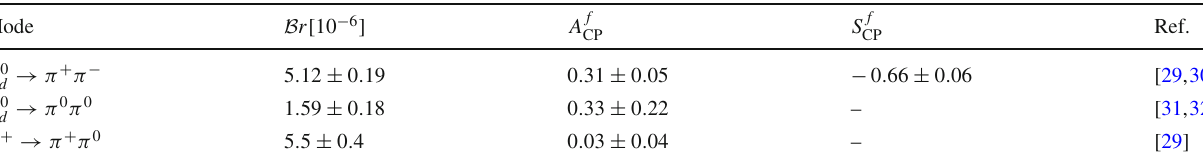
Table 1 Overview of the currently available B → ππ measurements. Note that the branching ratios are actually CP-averaged quantities